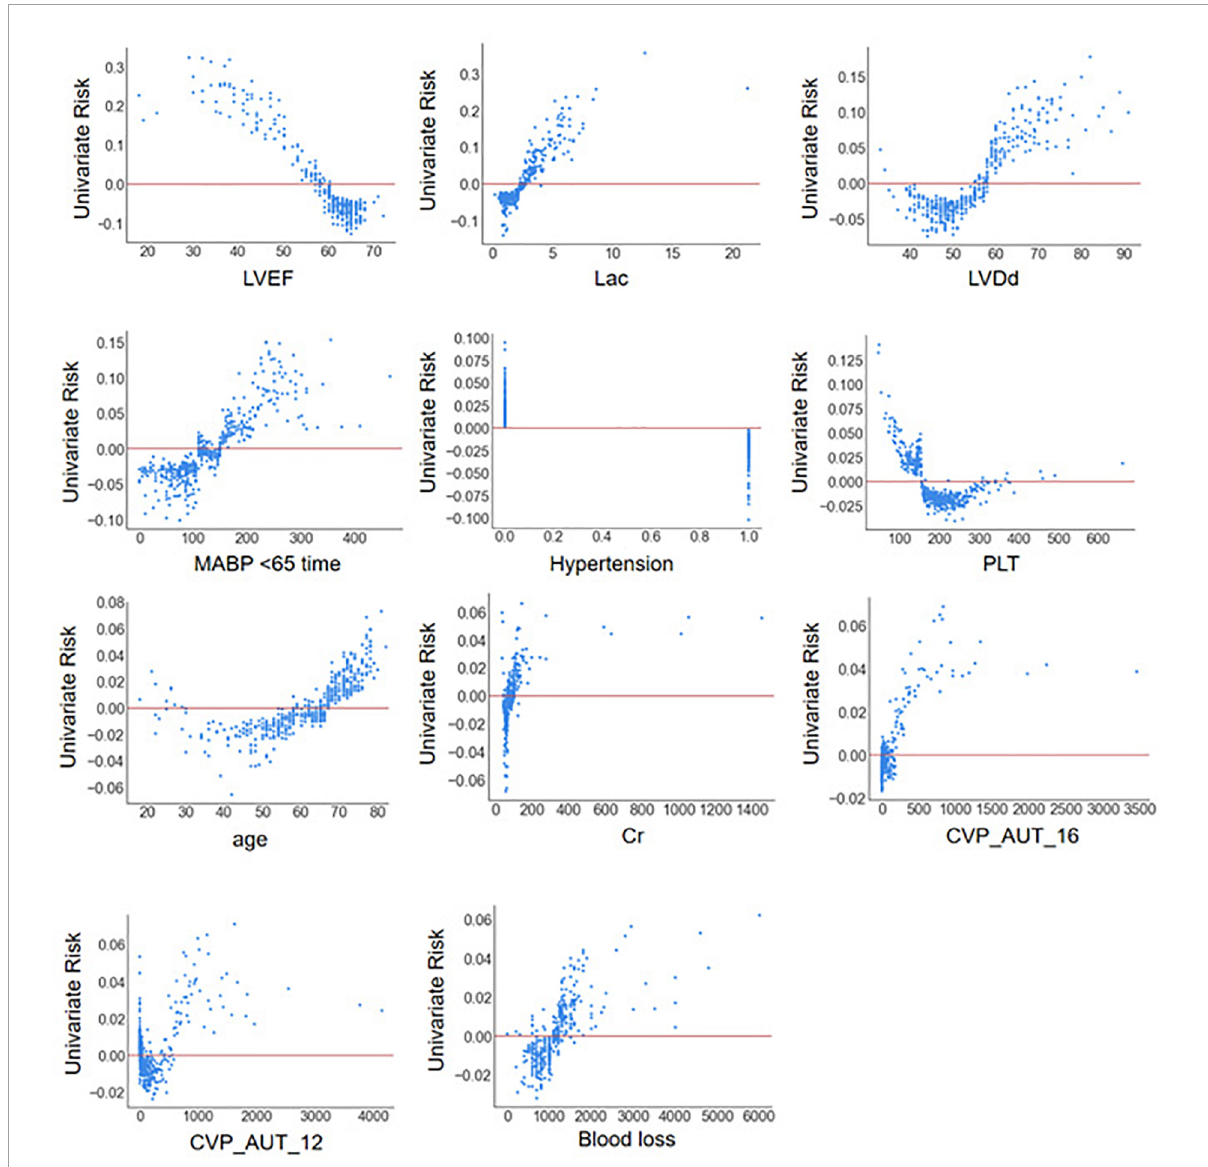
FIGURE4 SHAP dependence plot of the reduced RF model. ECHO, echocardiography; LVDd, left ventricular diastolic diameter; LVPWT, left ventricular posterior wall thickness; LVEF, left ventricular ejection fraction; WBC, white blood cell count; NEU, neutrophil properties; Cr, blood creatinine; BUN, blood urea nitrogen; AST, aspartate aminotransferase; Lac, blood lactate; CPB, cardiopulmonary bypass; AO, aortic occlusion; CABG, coronary artery bypass graft; MABP < 65 time, cumulative time of mean artery blood pressure lower than 65 mmHg; MABP < 60 time, cumulative time of mean artery blood pressure lower than 60 mmHg; MABP < 55 time, cumulative time of mean artery blood pressure lower than 55 mmHg; MABP < 50 time, cumulative time of mean artery blood pressure lower than 50 mmHg; MABP_AUT_65, total area under curve below threshold mean artery blood pressure 65 mmHg; MABP_AUT_60, total area under curve below threshold mean artery blood pressure 60 mmHg; MABP_AUT_55, total area under curve below threshold mean artery blood pressure 55 mmHg; MABP_AUT_50, total area under curve below threshold mean artery blood pressure 50 mmHg; MABP_TWA_65, time weighted average mean artery blood pressure below threshold 65 mmHg; MABP_TWA_60, time weighted average mean artery blood pressure below threshold 60 mmHg; MABP_TWA_55, time weighted average mean artery blood pressure below threshold 55 mmHg; MABP_TWA_50, time weighted average mean artery blood pressure below threshold 50 mmHg; CVP > 12 time, cumulative time of central venous pressure upper than 12 mmHg; CVP > 16 time, cumulative time of central venous pressure upper than 16 mmHg; CVP > 20 time, cumulative time of central venous pressure upper than 20 mmHg; CVP_AUT_12, total area under curve above threshold central venous pressure 12 mmHg; CVP_AUT_16, total area under curve above threshold central venous pressure 16 mmHg; CVP_AUT_20, total area under curve above threshold central venous pressure 20 mmHg; CVP_TWA_12, time weighted average central venous pressure above threshold 12 mmHg; CVP_TWA_16, time weighted average central venous pressure above threshold 16 mmHg; CVP_TWA_20, time weighted average central venous pressure above threshold 20 mmHg; LCOS, low cardiac output